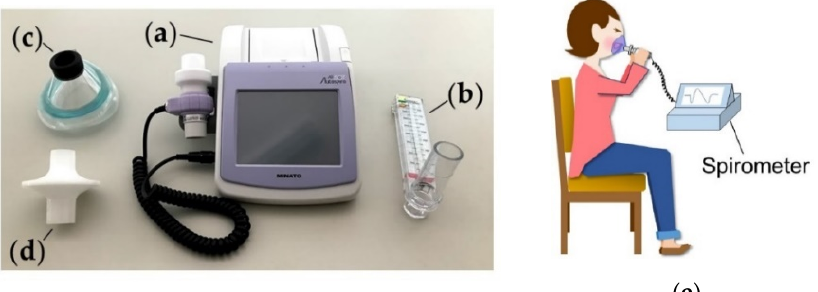
Figure 2. Cough peak flow (CPF) measurement devices and posture. ( a ) Spirometer. ( b ) Peak flow meter. ( c ) Face mask. ( d ) Infection prevention filter. ( e ) Conventional CPF measurement method.